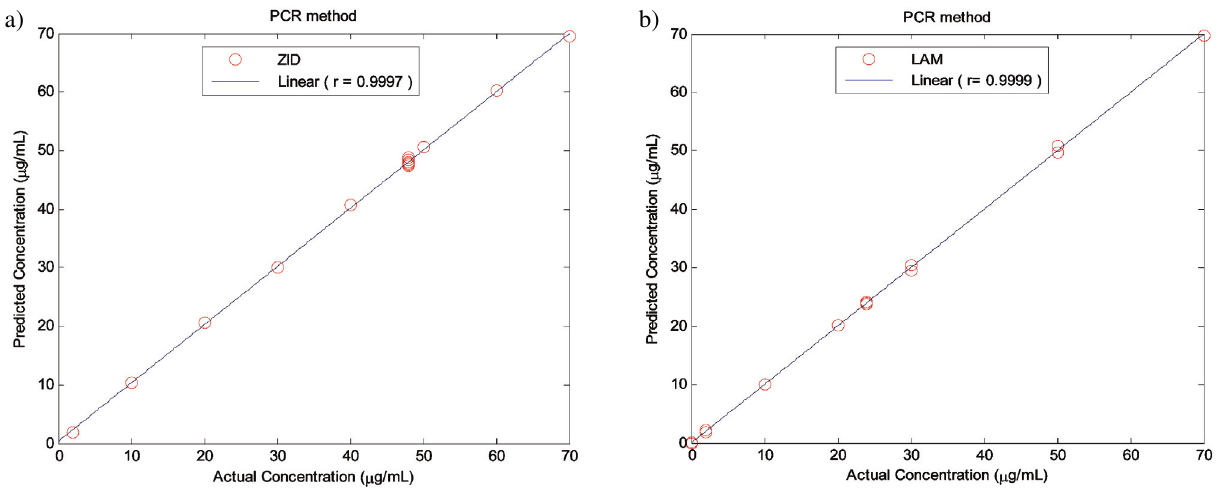
Figure 5. Plot of the actual and predicted concentrations in the prediction step by using the PCR method with four components for ZID (a) and LAM (b)